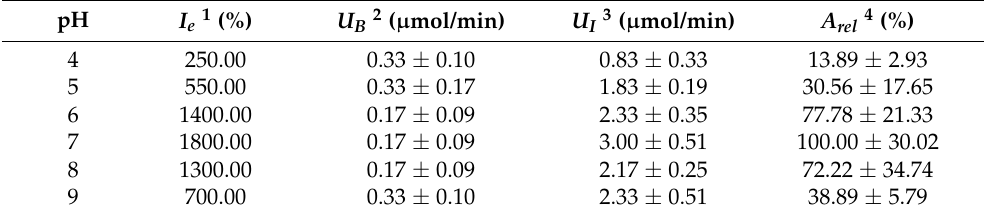
Table 5. Effect of pH on the lipolytic activity of AA-ANL immobilized onto polyacrylic IB-150-A